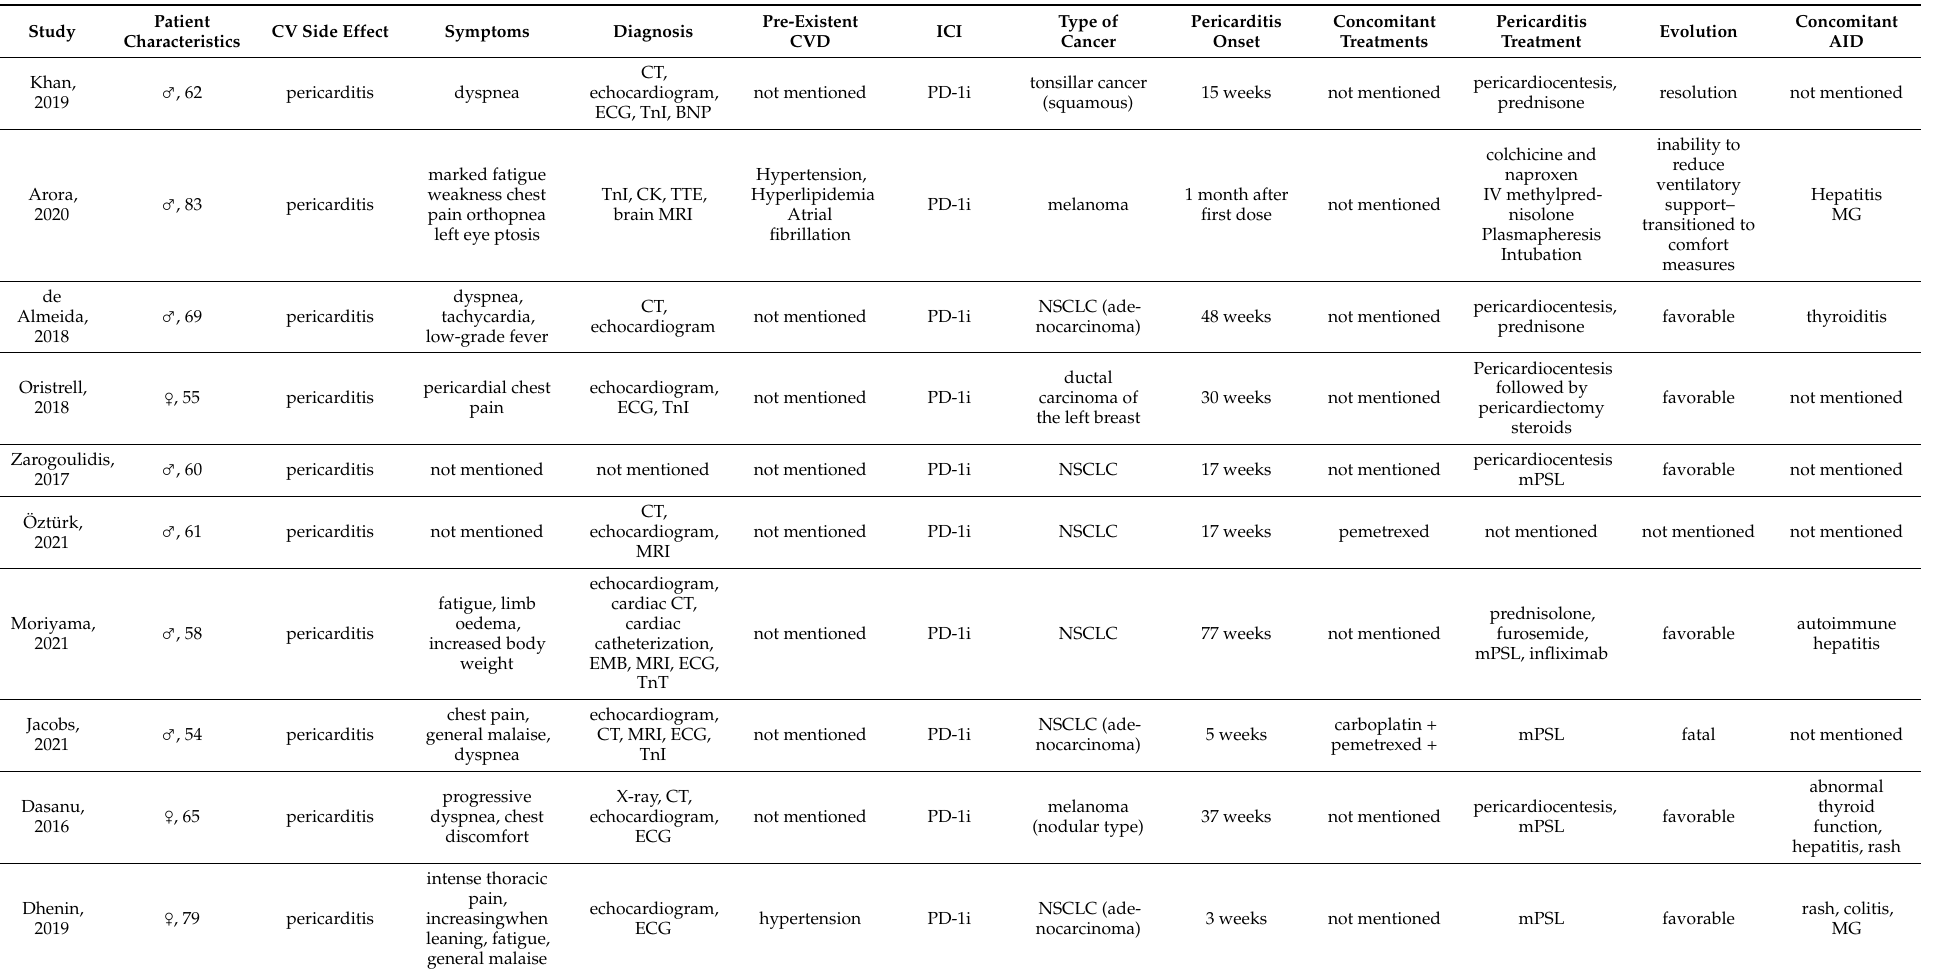
Table 2. Case reports with ICI-associated